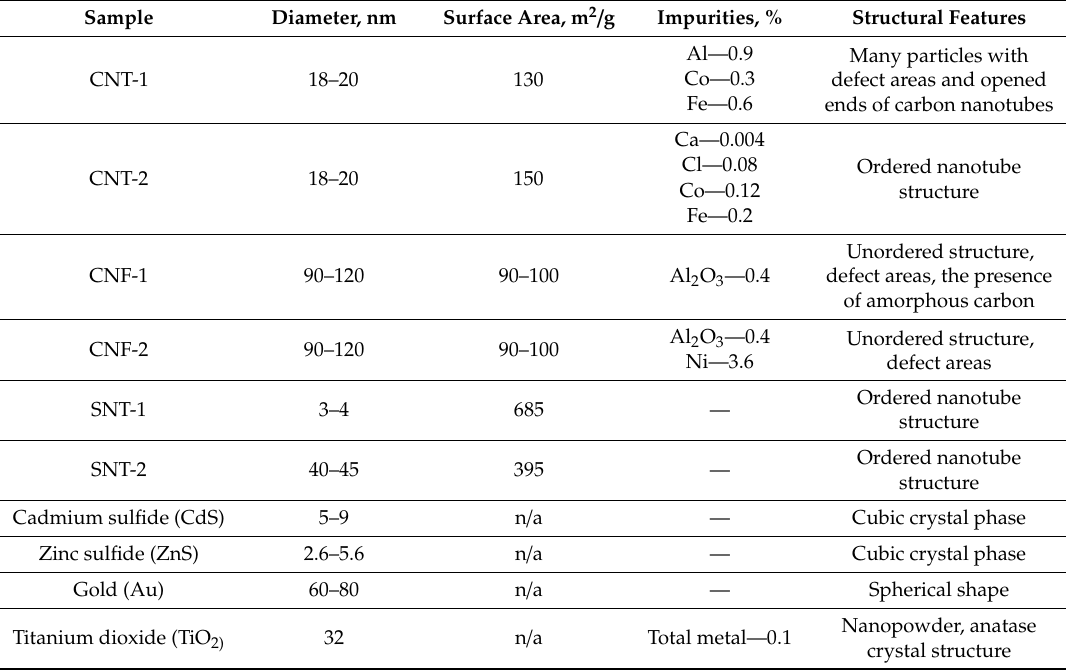
Table 1. Characteristics of the nanoparticles (NPs) used in the